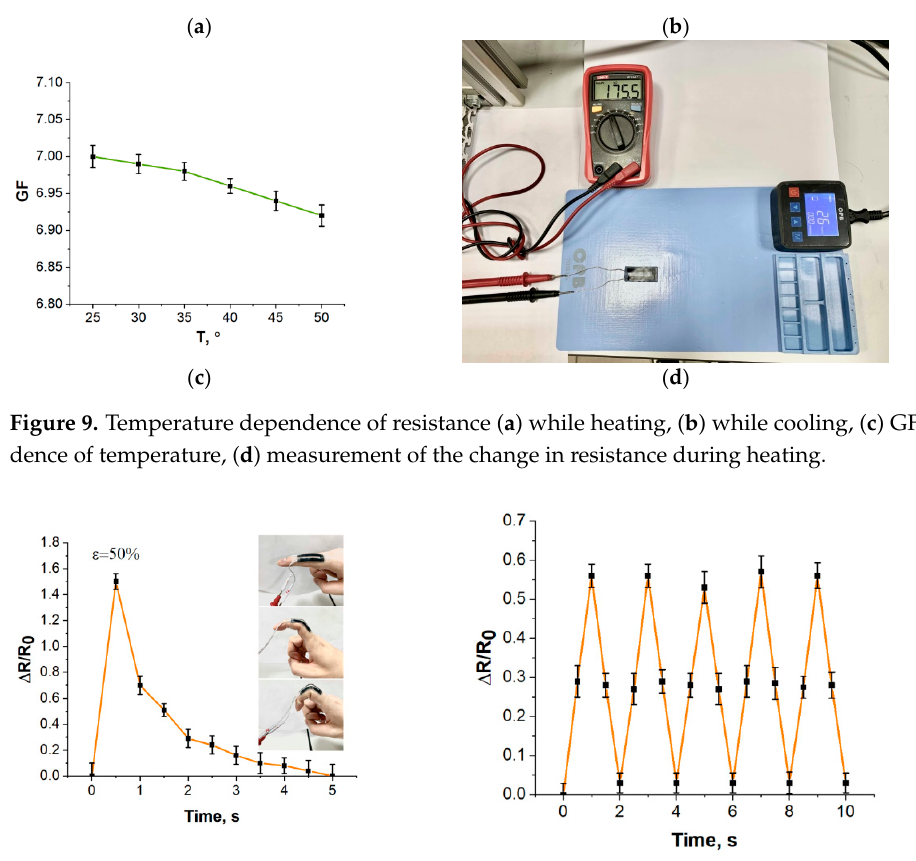
( b ) Figure 11. ( a ) Resistance value of the strain sensor after cyclic tests monitored for a month; ( b ) pro- cedure for real-time measurement of finger joint movement. Figure 11b shows the test process for measuring finger joint motion. The change in resistance of the strain sensor caused by flexion of the finger joint is transmitted to the